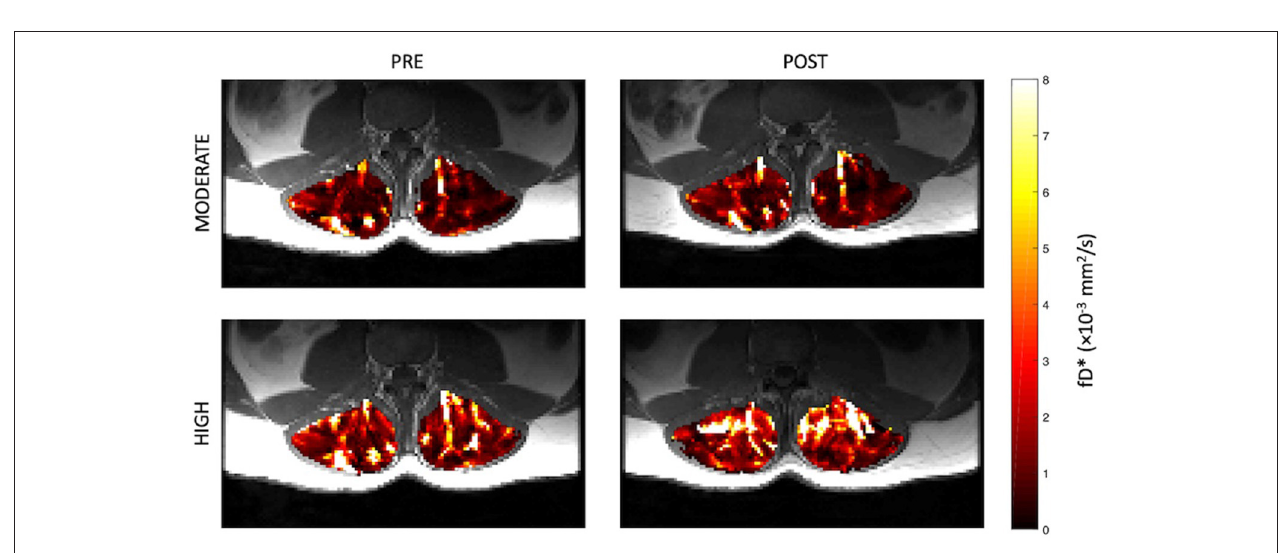
FIGURE 6 | Representative parameter maps of diffusion coefficient, D, before and after both moderate (top) and high (bottom) intensity resisted lumbar extension exercise.